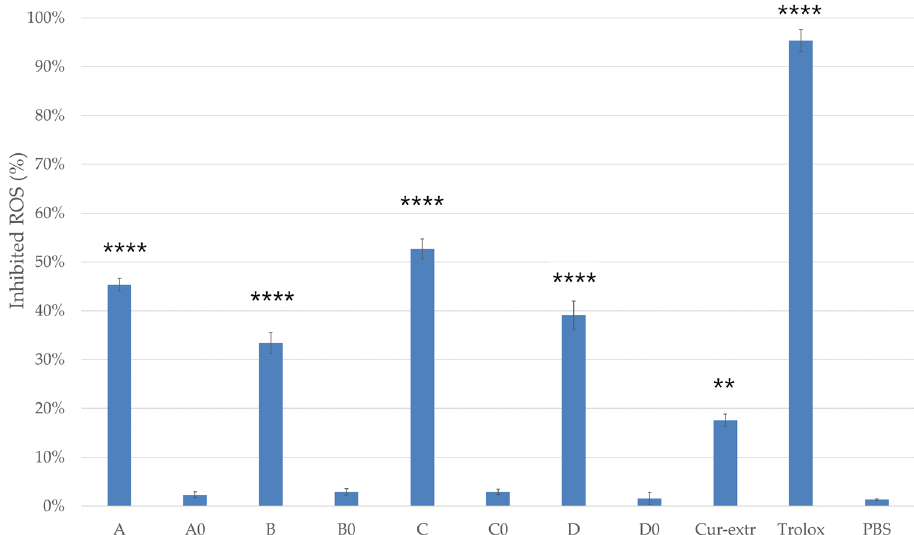
Figure 8. DPPH-scavenging activity of the compositions (5 w/v %). As positive control, Trolox (10.0 µM) dissolved in ethanol (96%) was used. As negative control, 2.0 mL of DPPH solution (0.06 mM) diluted with 1.0 mL absolute ethanol and PBS were applied. Data presented as mean ± SD ( n = 6). Ordinary one-way ANOVA with Dunnett’s multiple comparison test was performed to compare the different formulations with PBS. The ** and **** indicate statistically significant differences at p < 0.01 and p < 0.0001.